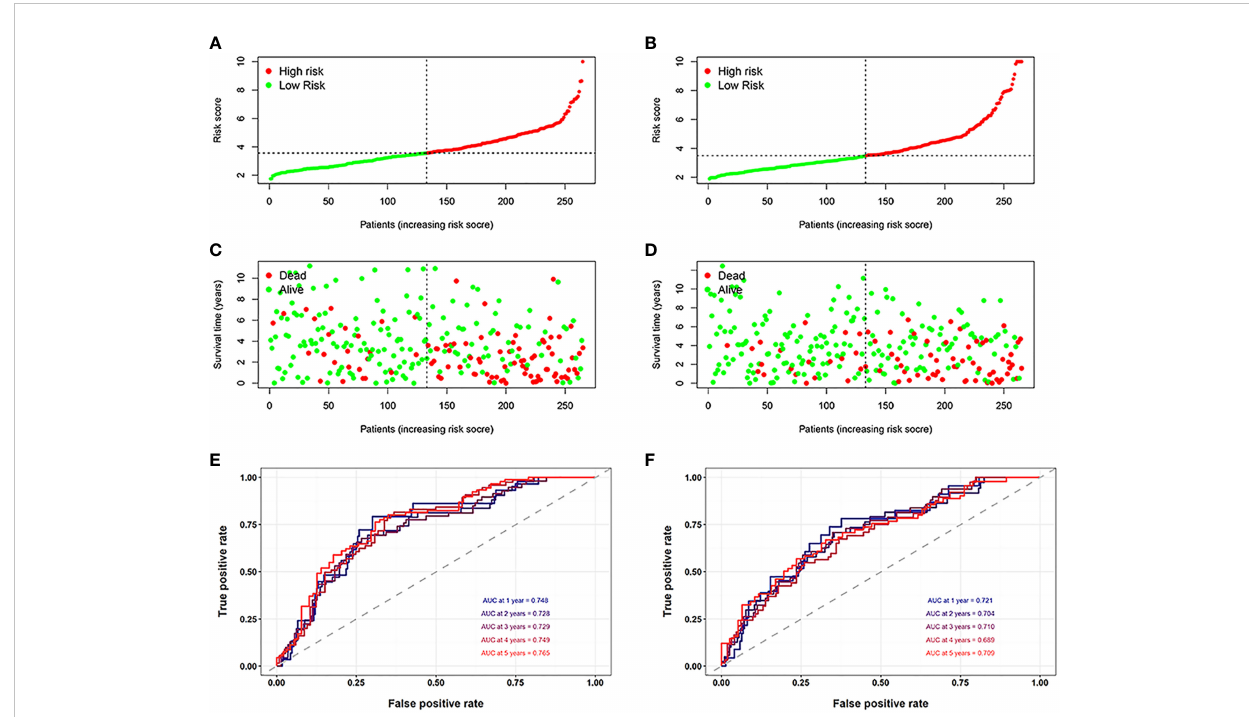
FIGURE 6 Assessment of the model. (A, B) The distribution of patients ’ risk scores in the training and validation groups. (C, D) With increasing risk scores, the chance of patient death increased. (E, F) The ROC curves for 1, 2, 3, 4 and 5 years for both datasets.